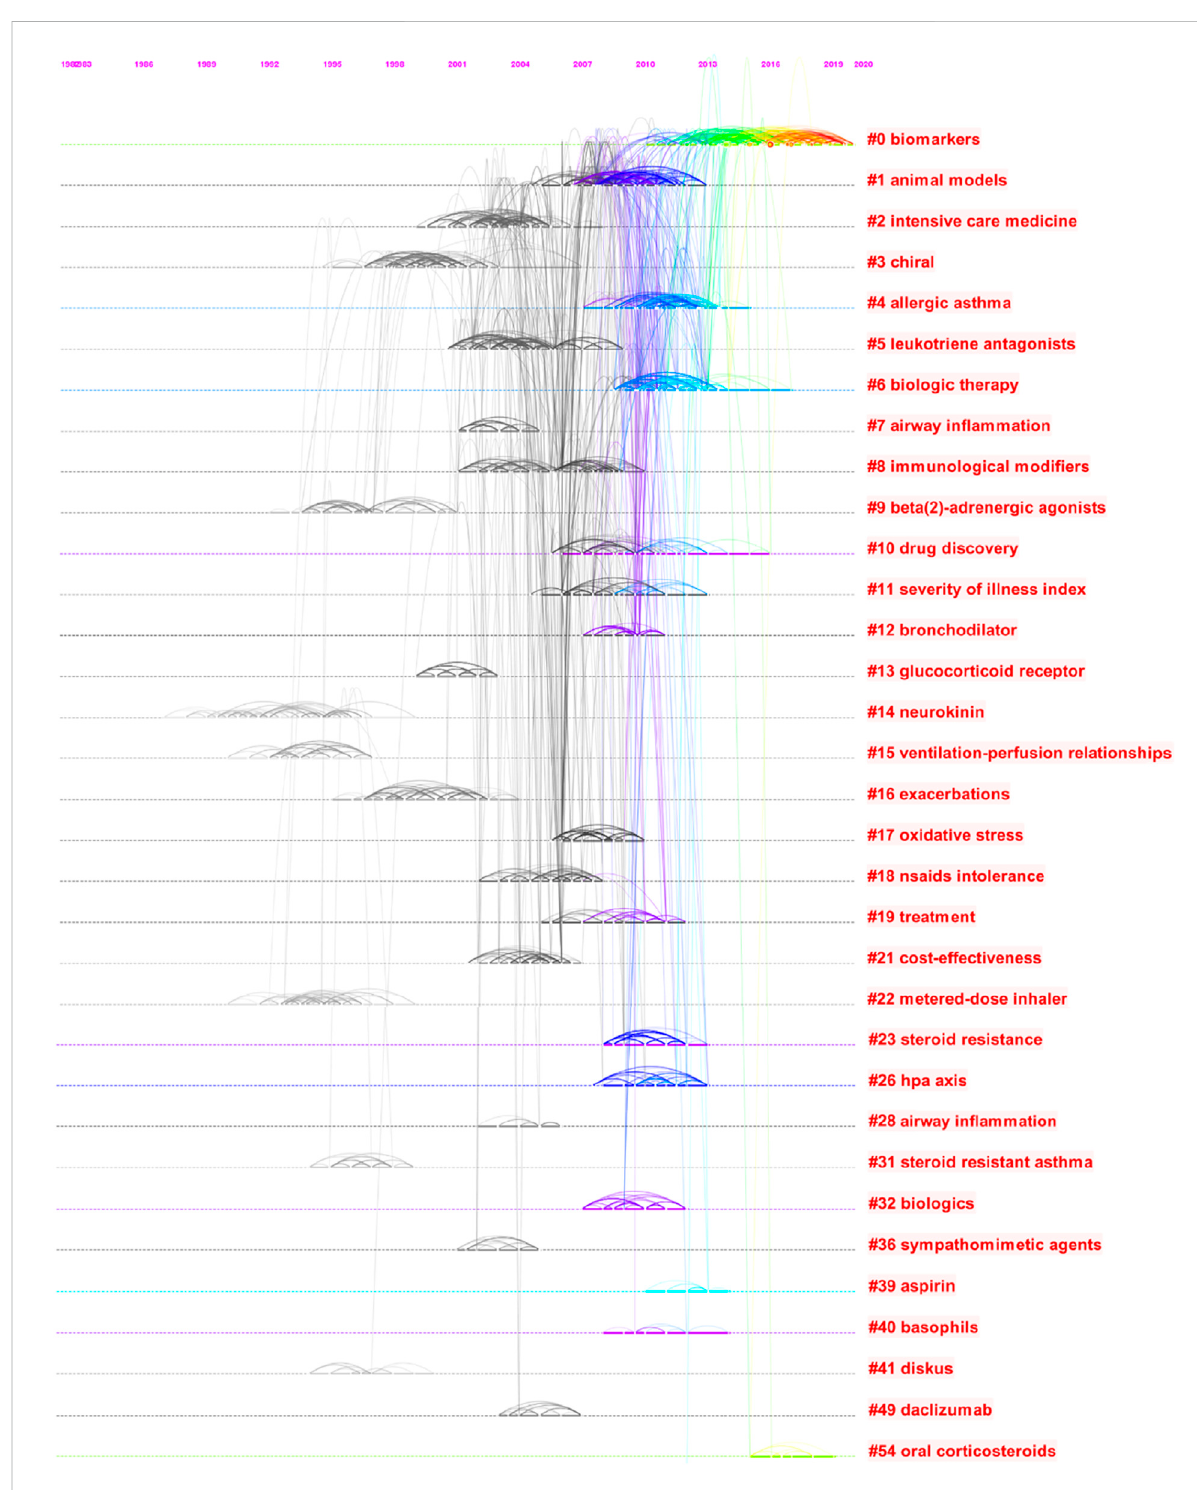
FIGURE 10 Timeline view for clusters of severe asthma drug-related study co-cited